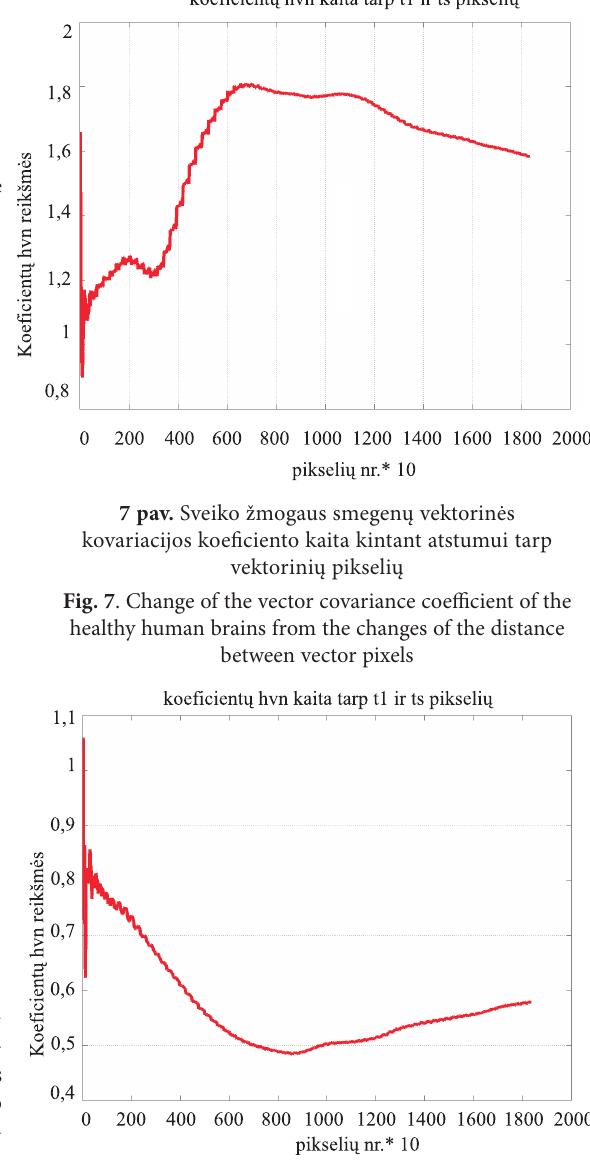
Fig. 8 . Change of the vector covariance coefficient of the damaged human brains from the changes of the distance between vector